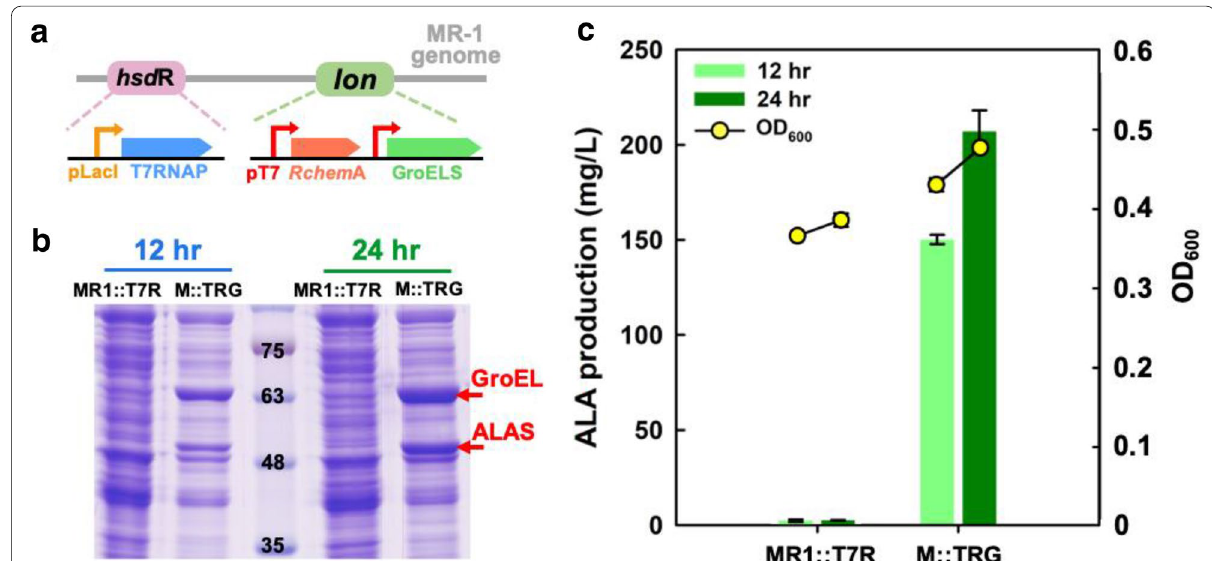
Fig. 7 Analysis of integrated strains in MM9 medium. a Schematic diagram of MR‑1 integration with T7 RNA polymerase (T7RNAP) under pLacI on the hsd R site and Rchem A and GroELS under dual T7 promoters on the lon gene. b SDS‑PAGE analysis of MR1::T7R and M::TRG. The arrows indicate the ALAS and GroEL at sizes of approximate 48 kDa and 63 kDa, respectively. c ALA production and biomass in terms by OD 600 were analyzed at 12 h and 24 h